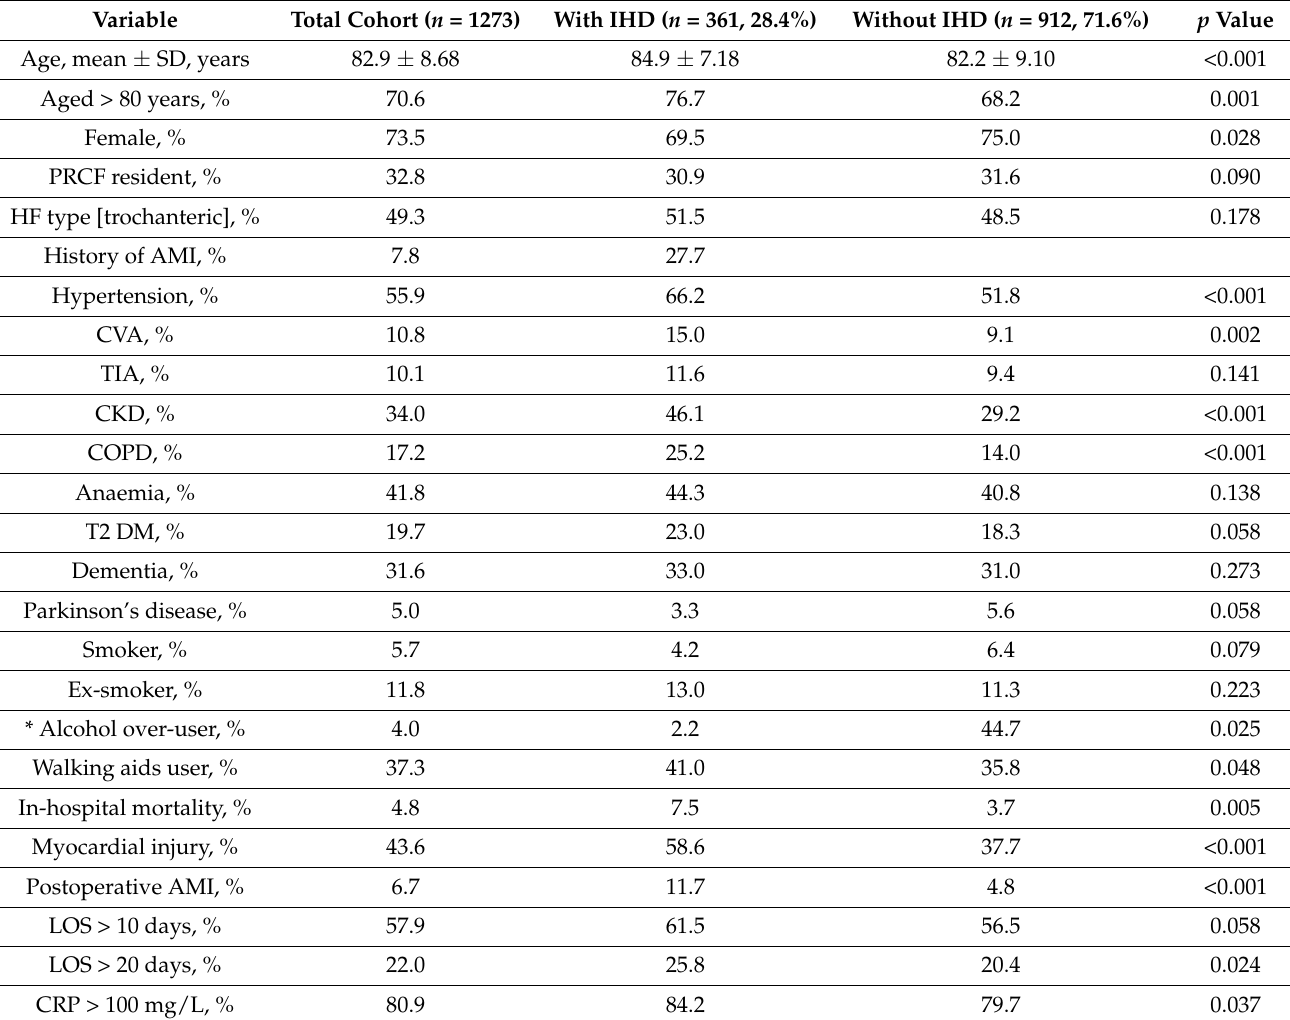
Table 1. Comparison of baseline clinical characteristics and outcomes in hip fracture patients with and without ischaemic heart disease